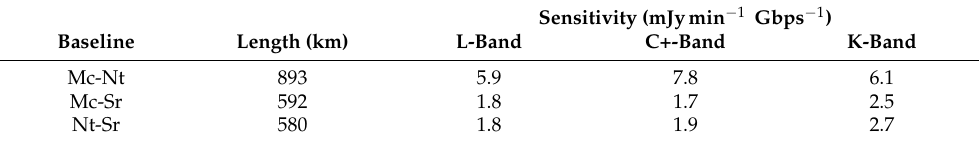
Table 3. INAF VLBI baseline length and